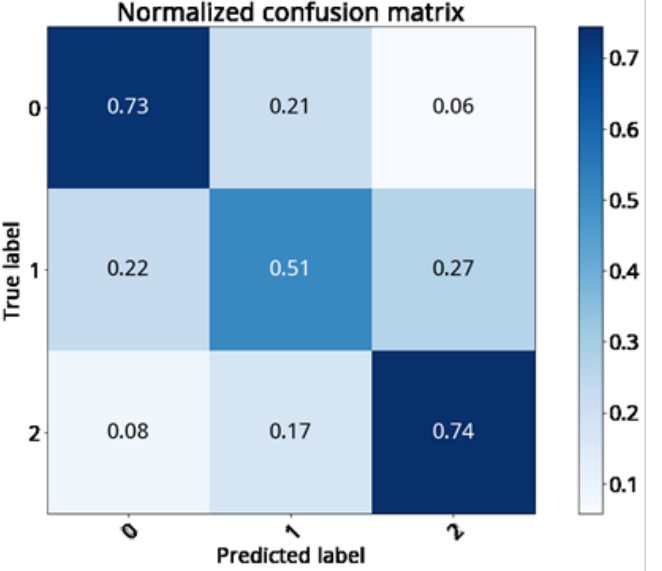
Figure 24. Confusion matrix of the cabbage growth stage classification from cupping, early heading, and mature stages. Table 11. Growth stage classification results of cabbage from early growth and mid-heading stages.